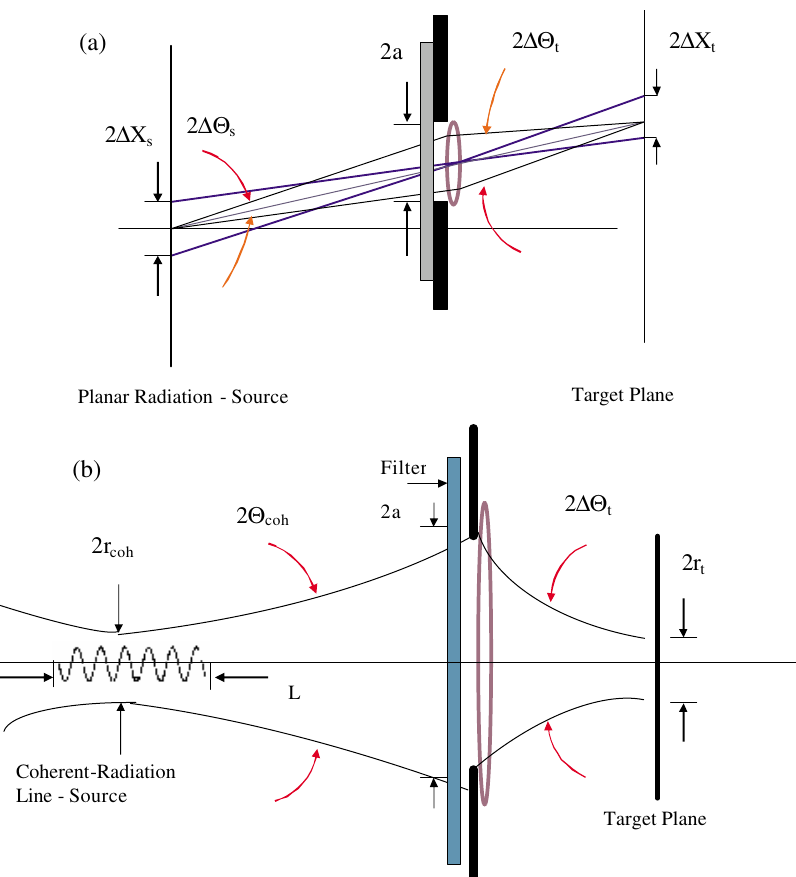
FIG. 3. (Color) Schematic (single thin lens) appertured optical delivery system from a radiation source to a target. (a) Spatial filtering and brightness measurement of an incoherent radiation source. (b) Effective spatial and angular apertures of a spatially coherent line radiation